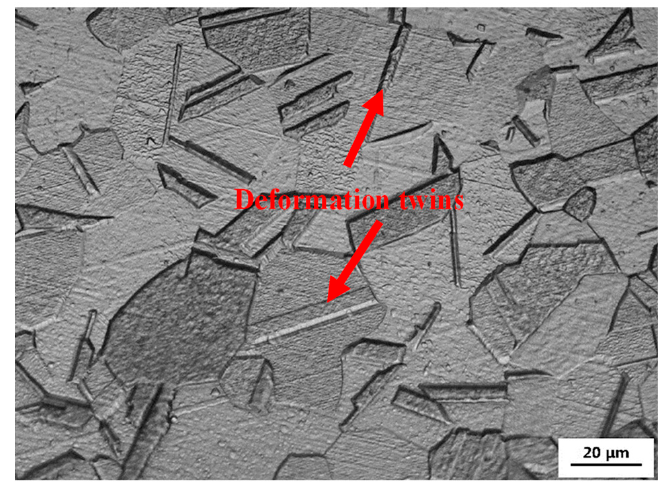
Figure 1. Cross section OM micrographs of base wire.